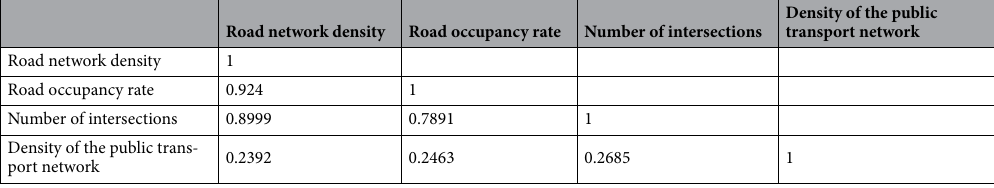
Table 2. Correlation coefficient R 2 of